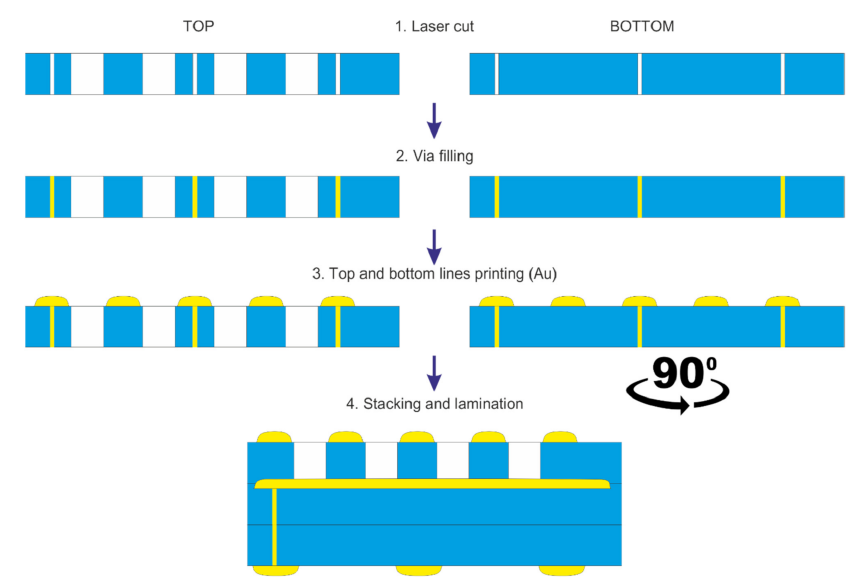
Figure 5. The manufacturing process using an LTCC insulation layer (Multi Substrate,